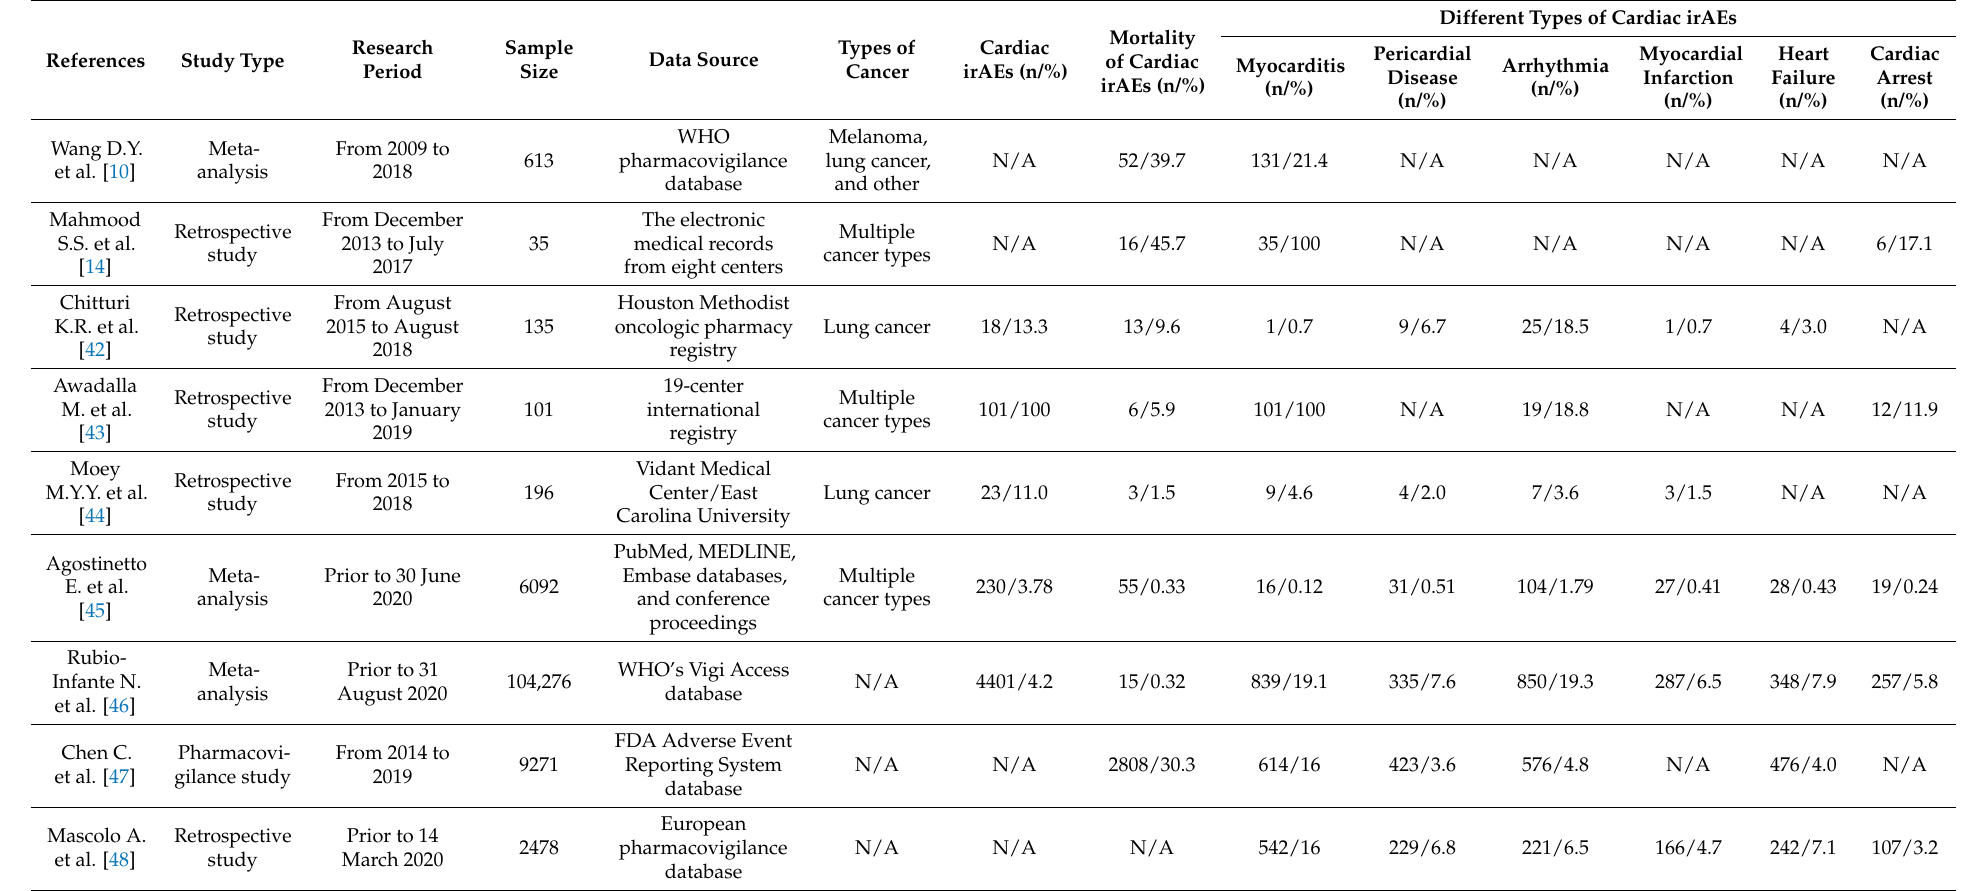
Table 2. The prime publications about cardiotoxicity related to immune checkpoint inhibitors from